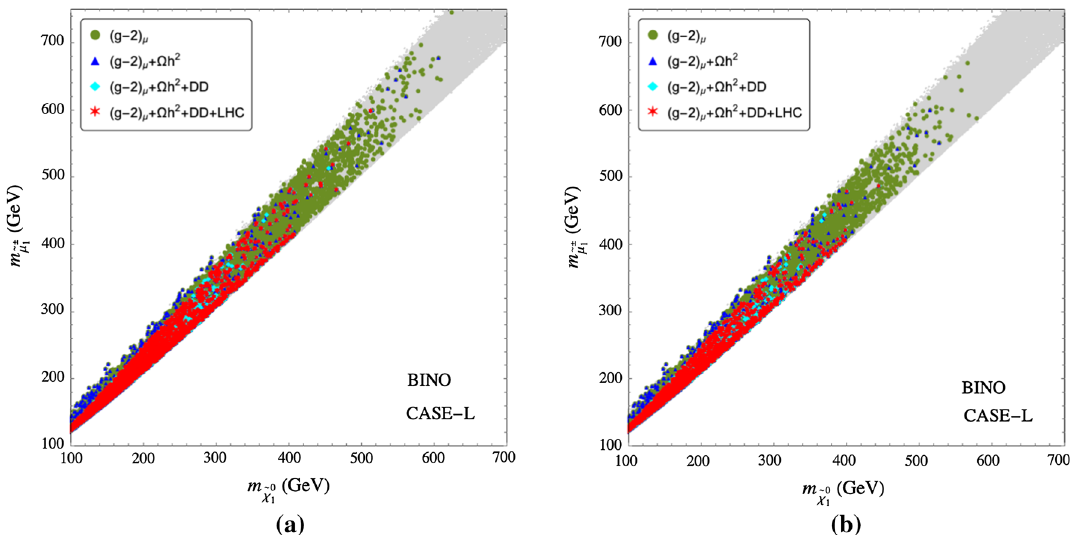
Fig. 15 The results of our parameter scan in the m ˜ χ 0 limits (right) from ( g − 2 ) μ . The color coding is as in Fig.